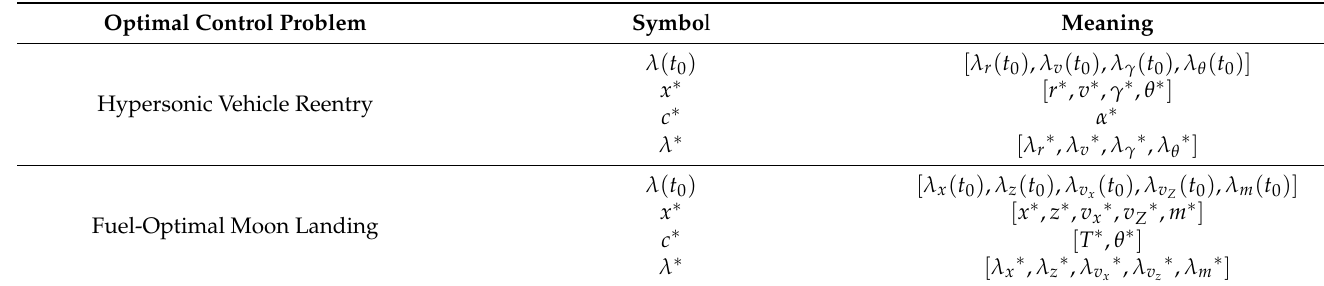
Table 3. Symbolic meaning of two OCPs.